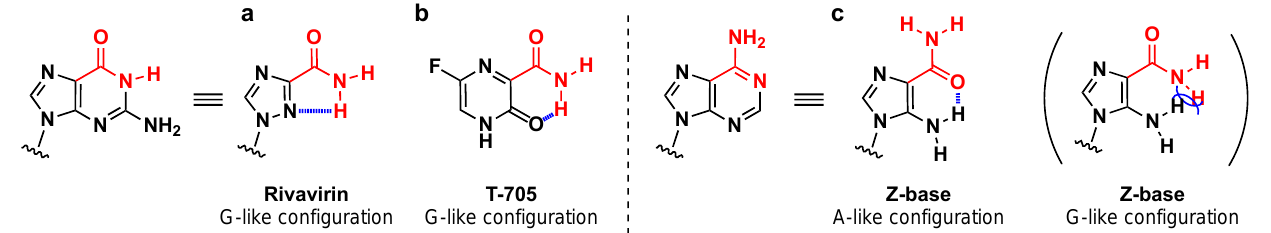
Figure 6. Possible configurations of nucleoside analogs with a rotatable carboxamide group on the nucleobases. Rotatable carboxamide groups are highlighted in red. Blue hashed lines indicate hydrogen bonding interactions.